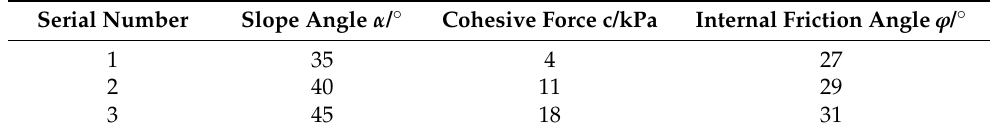
Table 1. Values for sensitivity analysis Figure 5. Schematic diagram of water level optimization.